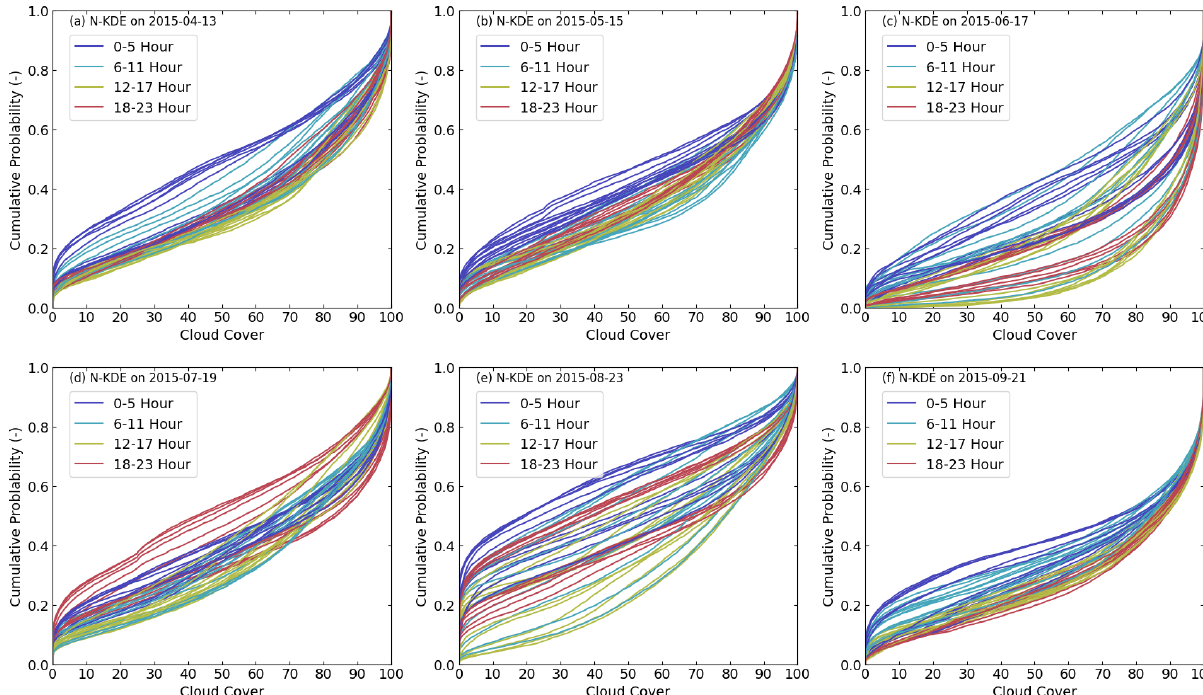
Figure 3. The cumulative KDE of cloud cover for the six simulation cases in UTC time. The colors distinguish the different cloud cover. The different colors represent different time periods in a day, as shown in the legend.